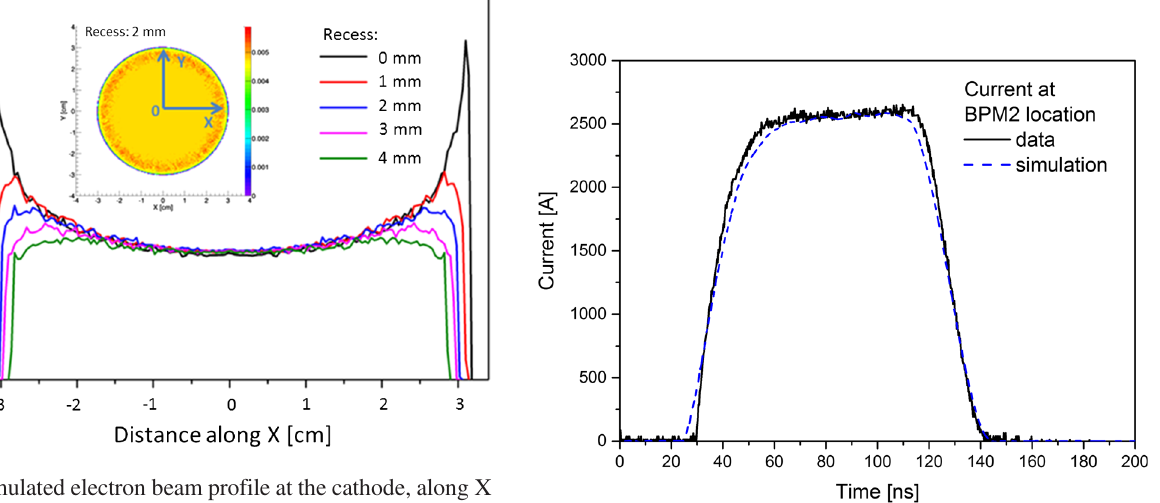
FIG. 5. Simulated electron beam profile at the cathode, along X at Y ¼ 0 , on the flattop voltage for a 3.175 cm cathode radius for five recess values ranging from 0 to 4 mm. The inserted image is a 2D plot of the simulated beam distribution at the cathode for a 2 mm recess.